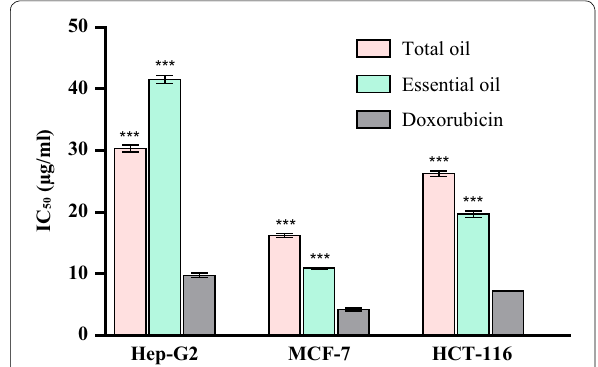
Fig. 2 In-vitro cytotoxic activity of Myrrh hexane extract and essential oil on the tested cell lines. Significant differences among means of different treatments were separated using Bonferroni posttests at p 0.05 (n 3) with all treatments compared to the ≤ = control; doxorubicin. ***p <